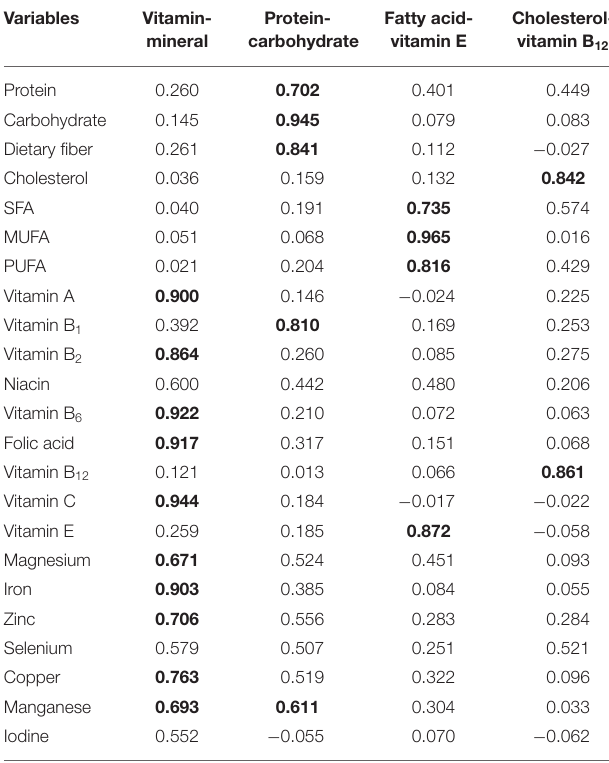
TABLE 1 | Principal component analysis of nutrient